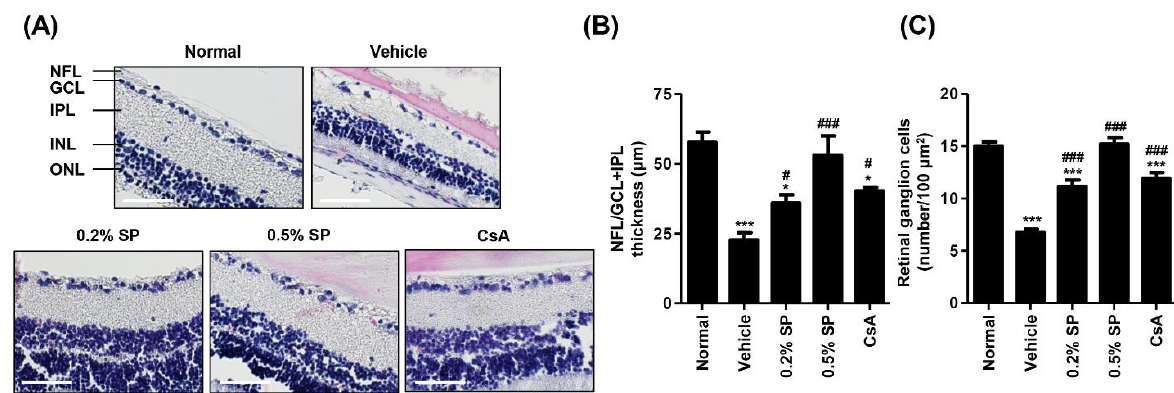
Figure 6. Effect of spermidine on retinal ganglion cell loss after topical exposure to PM 2.5 in SD rats. ( A ) Representative images of cross-sectioned retina with H&E staining. Nerve fiber layer (NFL), ganglion cell layer (GCL), inner plexiform layer (IPL), inner nuclear layer (INL) and outer nuclear layer (ONL) are indicated. Scale bar; 50 μm. ( B ) Thickness of NFL/GCL +IPL layers. ( C ) The numbers of cells in GCL of 100 μm 2 in five different sections were counted. Each bar indicates mean ± standard deviation ( n = 5). The statistical analyses were conducted using analysis of ANOVA-Tukey’s post hoc test between groups. * p < 0.05 and *** p < 0.001 compared to the normal group. # p < 0.05 and ### p < 0.001 compared to the vehicle group.